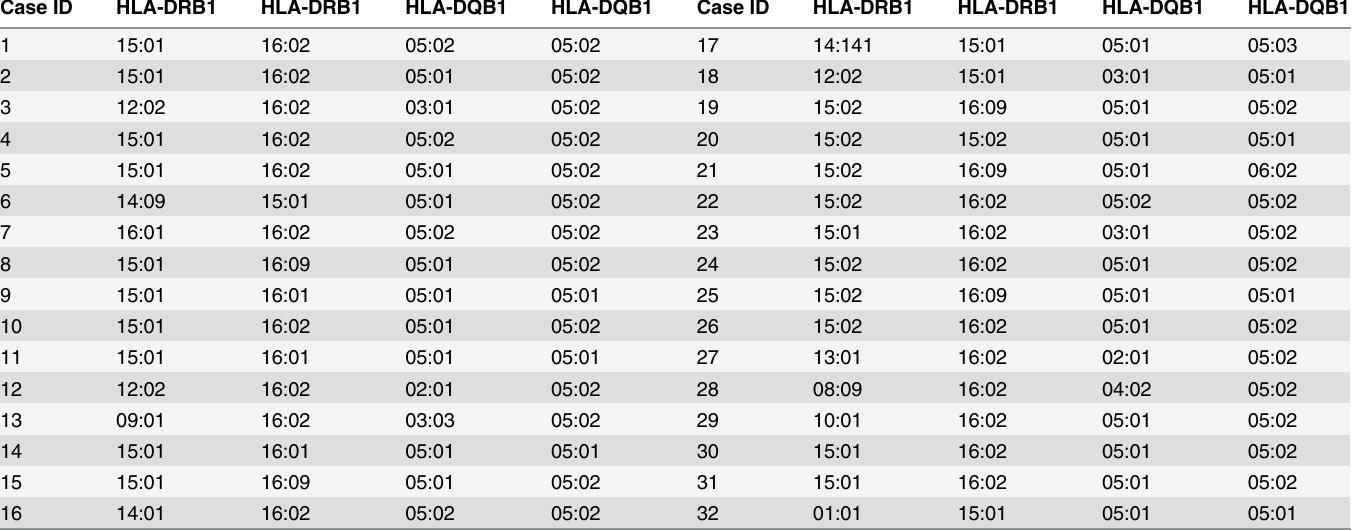
Table 2. HLA class II genotypes of 32 affected individuals with disseminated opportunistic infection and positive anti- IFN- γ autoantibody (case